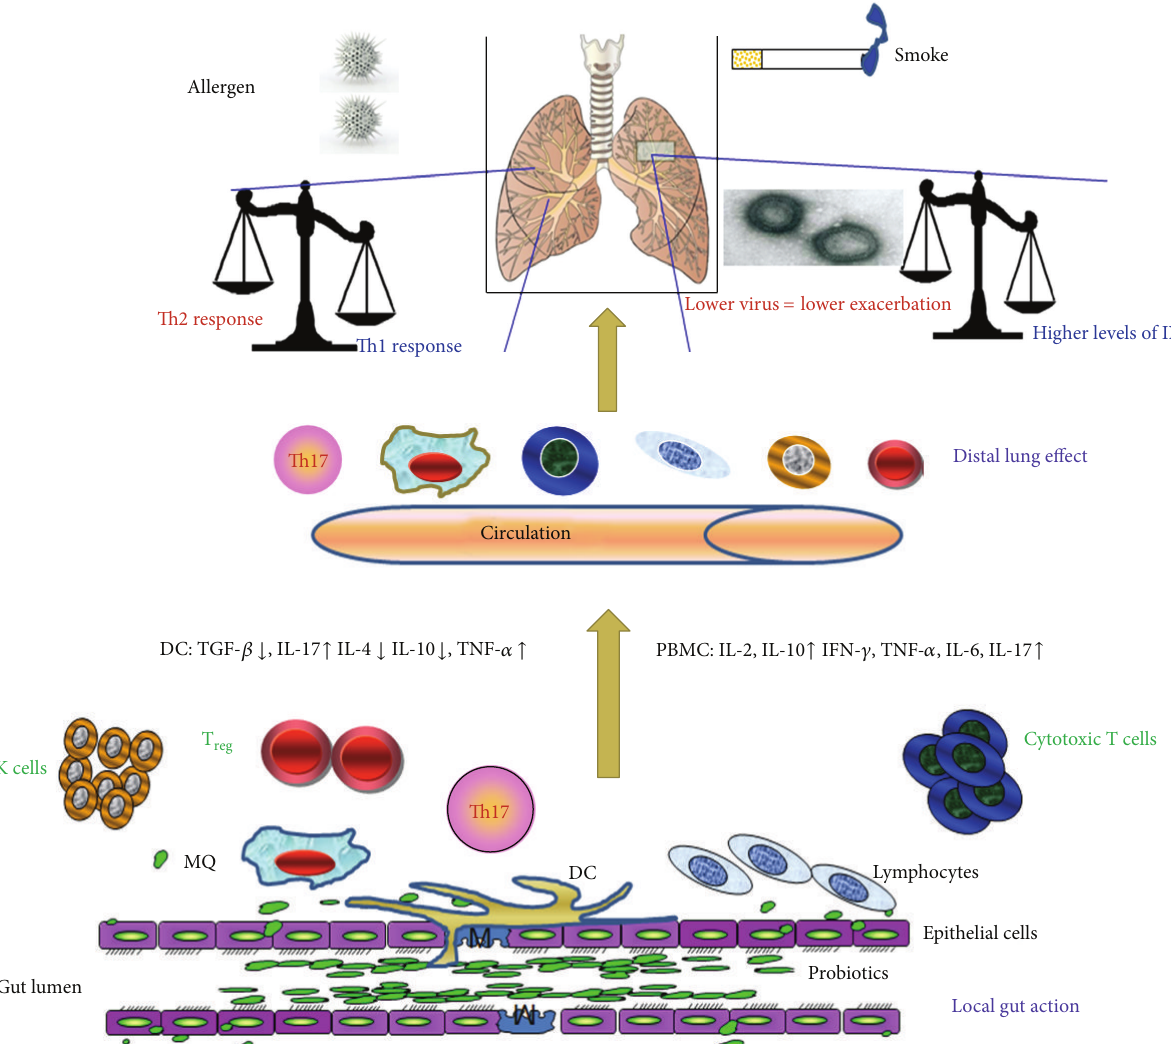
Figure 1: The putative immunomodulatory functions of probiotics on lung disease asthma and COPD . The immune and inflammatory drivers of allergic asthma (left side of figure) and of COPD (right side of figure) may be modified by strain-specific probiotics. The precise mechanisms by which gut-located probiotics can cause immunomodulation in the airway are unclear but may reflect changes in blood and local immune cells including T-cell